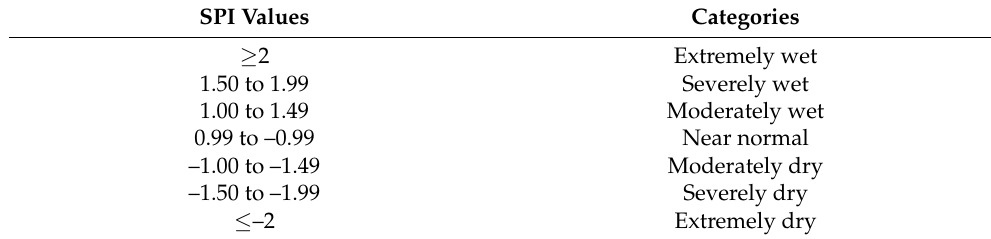
Table 2. Classification of SPI